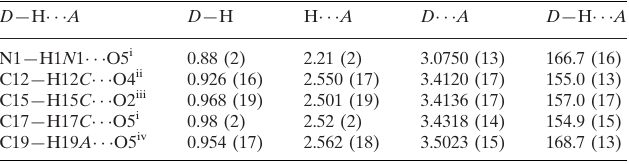
Data collection Bruker APEXII DUO CCD area- detector diffractometer Absorption correction: multi-scan ( SADABS ; Bruker, 2009) T min = 0.950, T max = 0.982